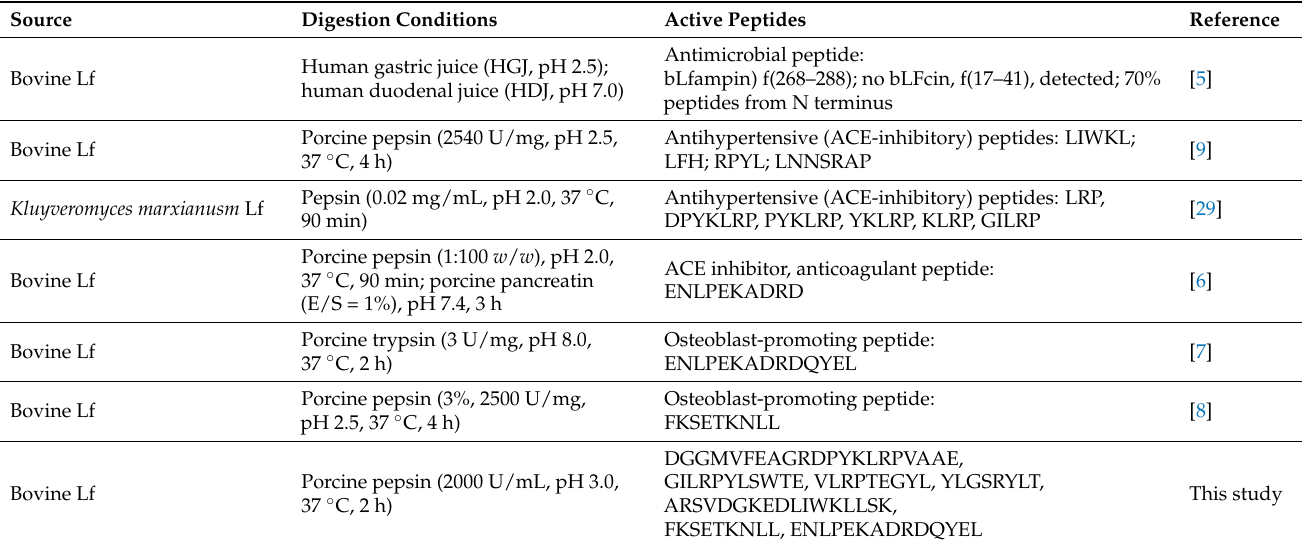
Table 3. Active peptide fragments from various lactoferrins reported and in this